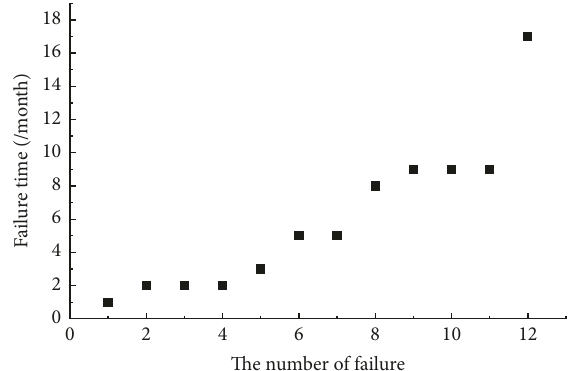
Figure 5: The historical data of the year 2010 of low-voltage switchgear.